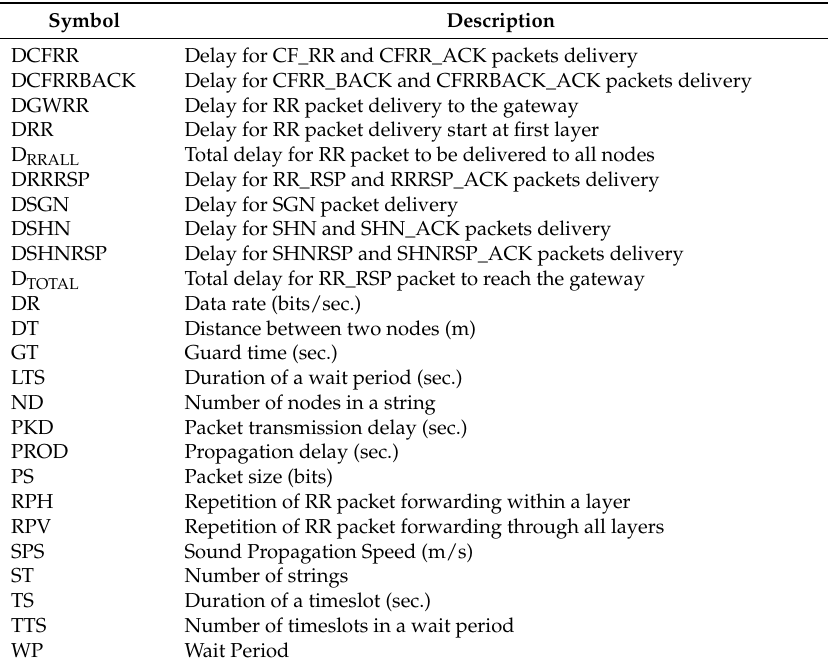
Table 2. List of the symbols used in the